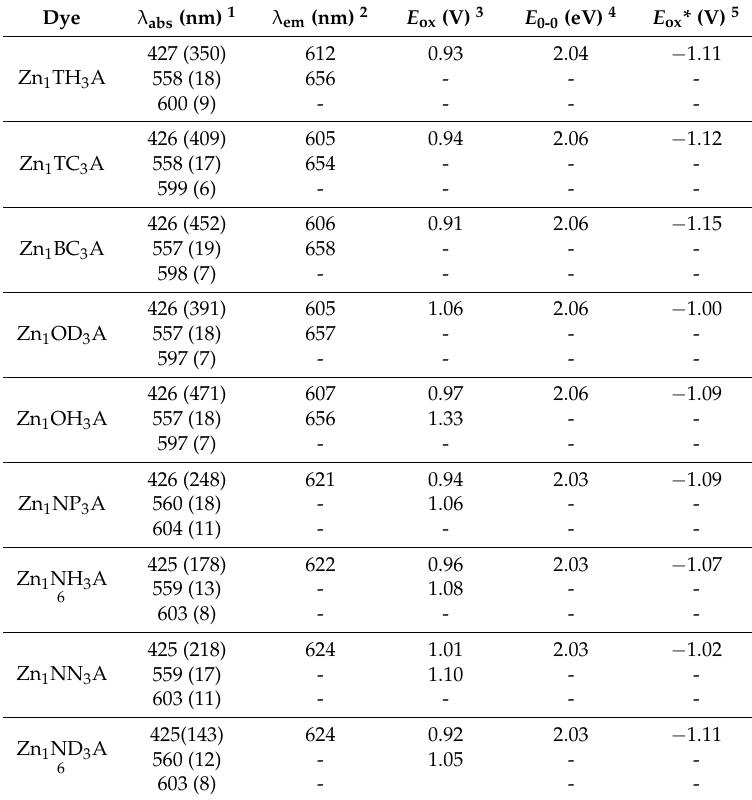
Table 1. Electrochemical Properties of studied porphyrins.